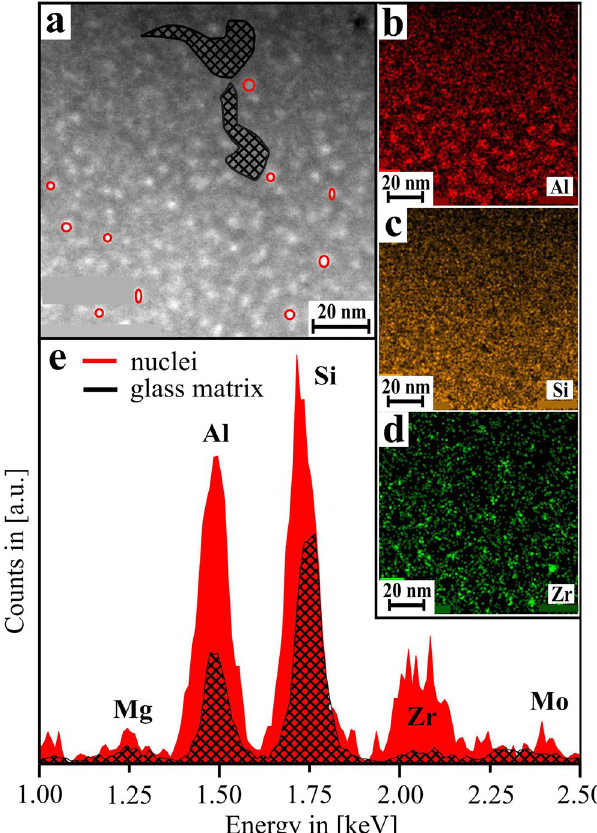
Figure 5. ( a ) STEM micrograph of a sample that was thermally treated at 725 °C for t = 1.75 h. ( b – d ) EDXS element distribution maps of the elements Al, Si and Zr, same sample area. ( f ) Red curve: accumulated EDX spectrum of single spectra gained via point measurements directly on the ZrO 2 nanocrystals (highlighted as red circles in ( a )); black curve: accumulated spectrum of the glassy sub-areas (highlighted as black hatched area in ( a )). Mo is an artifact signal from the TEM experimental